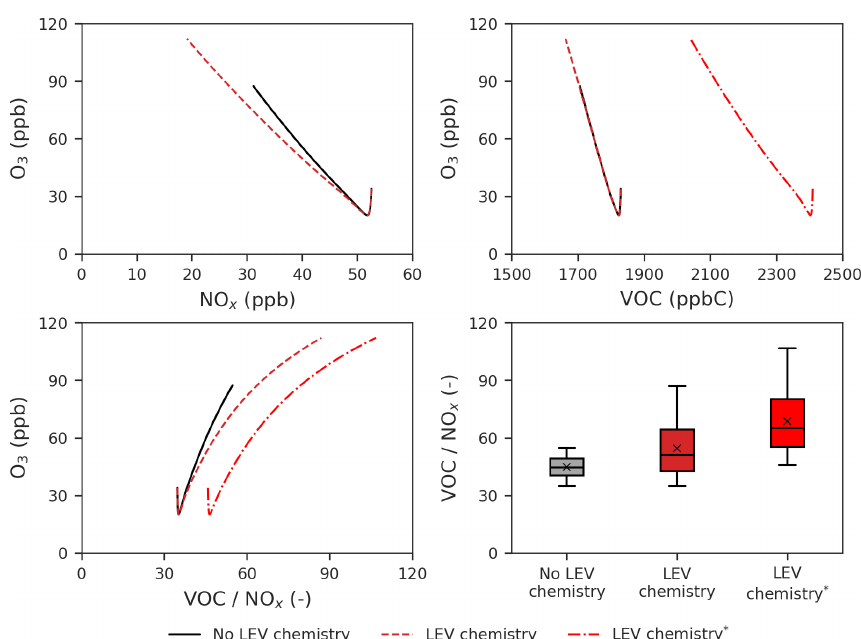
Figure 7. Effects of LEV chemistry on the O 3 vs. NO x , O 3 vs. VOCs and O 3 vs. VOC / NO x ratio relationships and on the VOC / NO x ratio. The two cases in red (with LEV chemistry) refer to the two ways in which VOCs were determined (with and without LEV_G and LEV_A). The asterisk refers to the inclusion of LEV_G and LEV_A in the total VOCs. All of the plots show simulation results at the 5h timescale. Note that findings shown here are determined over a range of F values depending on experimental conditions.